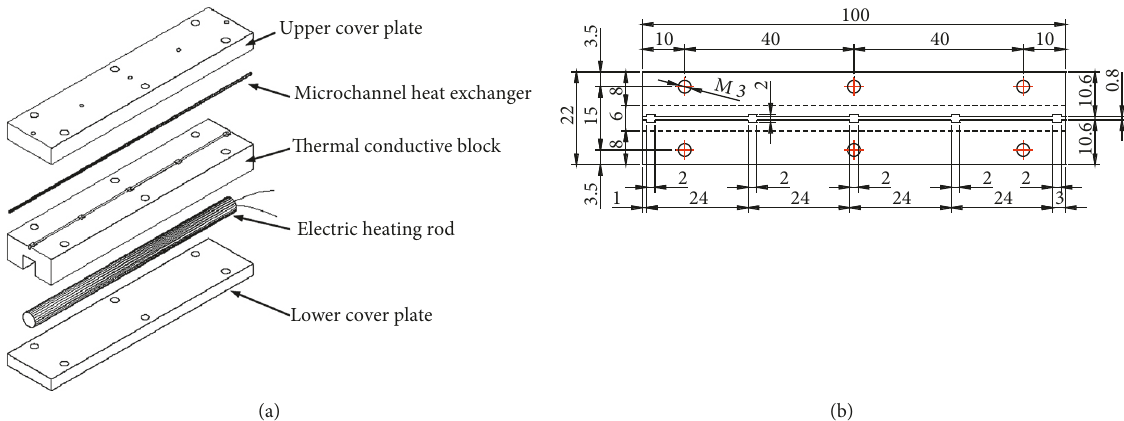
Figure 6: Schematic diagram of the heat transfer and liquid flow test sections in a microchannel: (a) schematic diagram; (b) structure size of heat-conducting